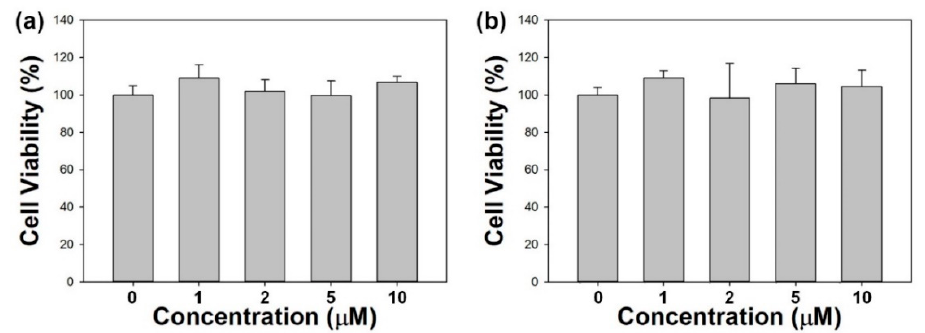
Figure 4. In vitro cytotoxic effects of Glu/Ce6 on ( a ) normal macrophages and ( b ) foam cells.